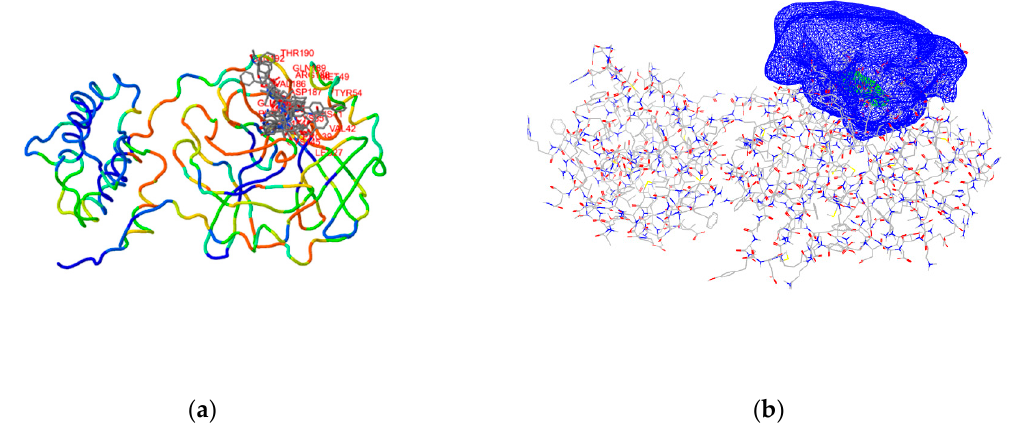
Figure 3. ( a ) Identification of the active site in the vicinity of the Cys145 using the ProBiS server and superposition of the small-molecule ligands from the locally aligned complexes at the 3CL pro active site; ( b ) the resulting extended docking grid calculated by Make Receptor of the OpenEye software.